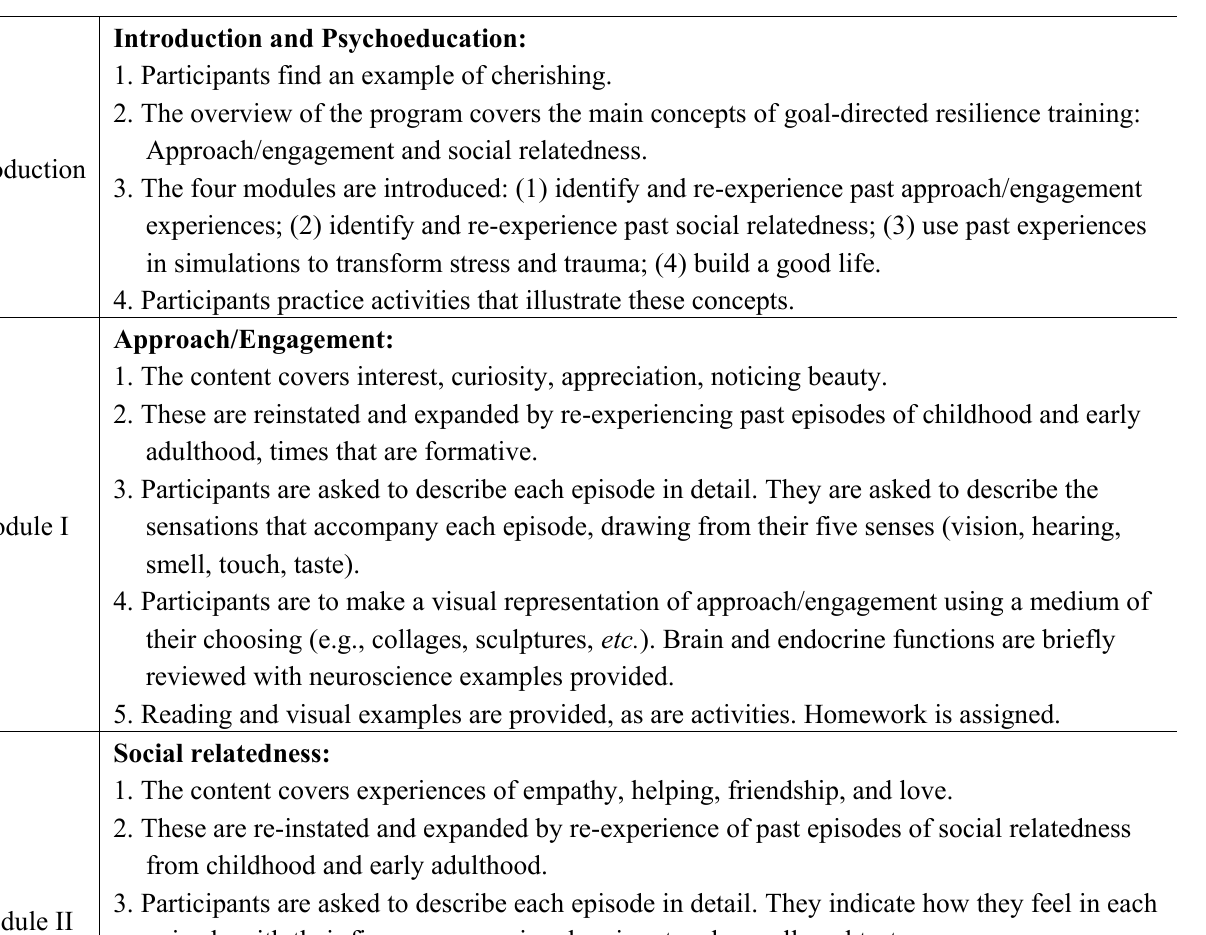
Table 1. A Modular Program for Resilience Training of Action and